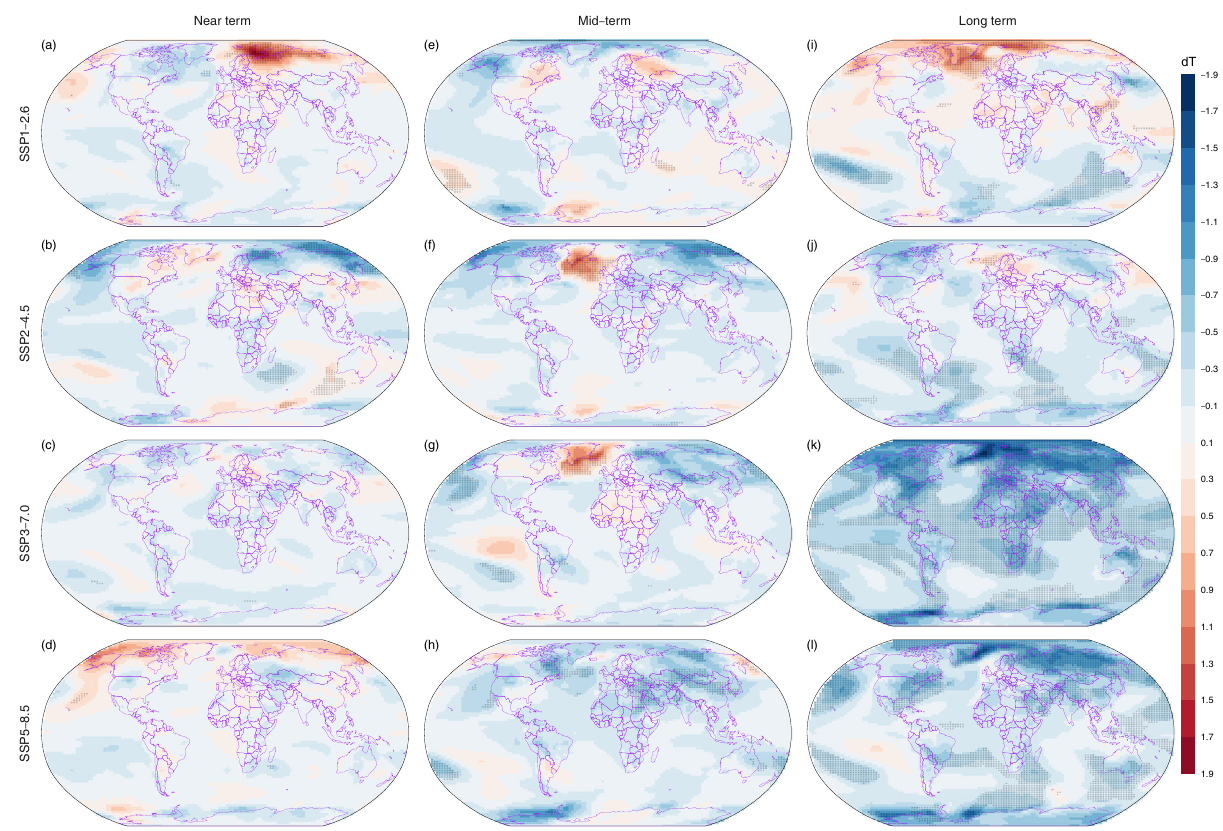
Fig.2|MeansurfacetemperaturedifferencebetweenChina ’ scarbonneutrality (CNCN) and default CMIP6 scenarios for four shared socioeconomic pathways (SSPs). Panels from left to right represent the near term (2021 – 2040, a – d ), mid-term (2041 – 2060, e – h ) and long term (2081 – 2100, i – l ), and panels from top to bottom represent SSP1-2.6, SSP2-4.5, SSP3-7.0 and SSP5-8.5,